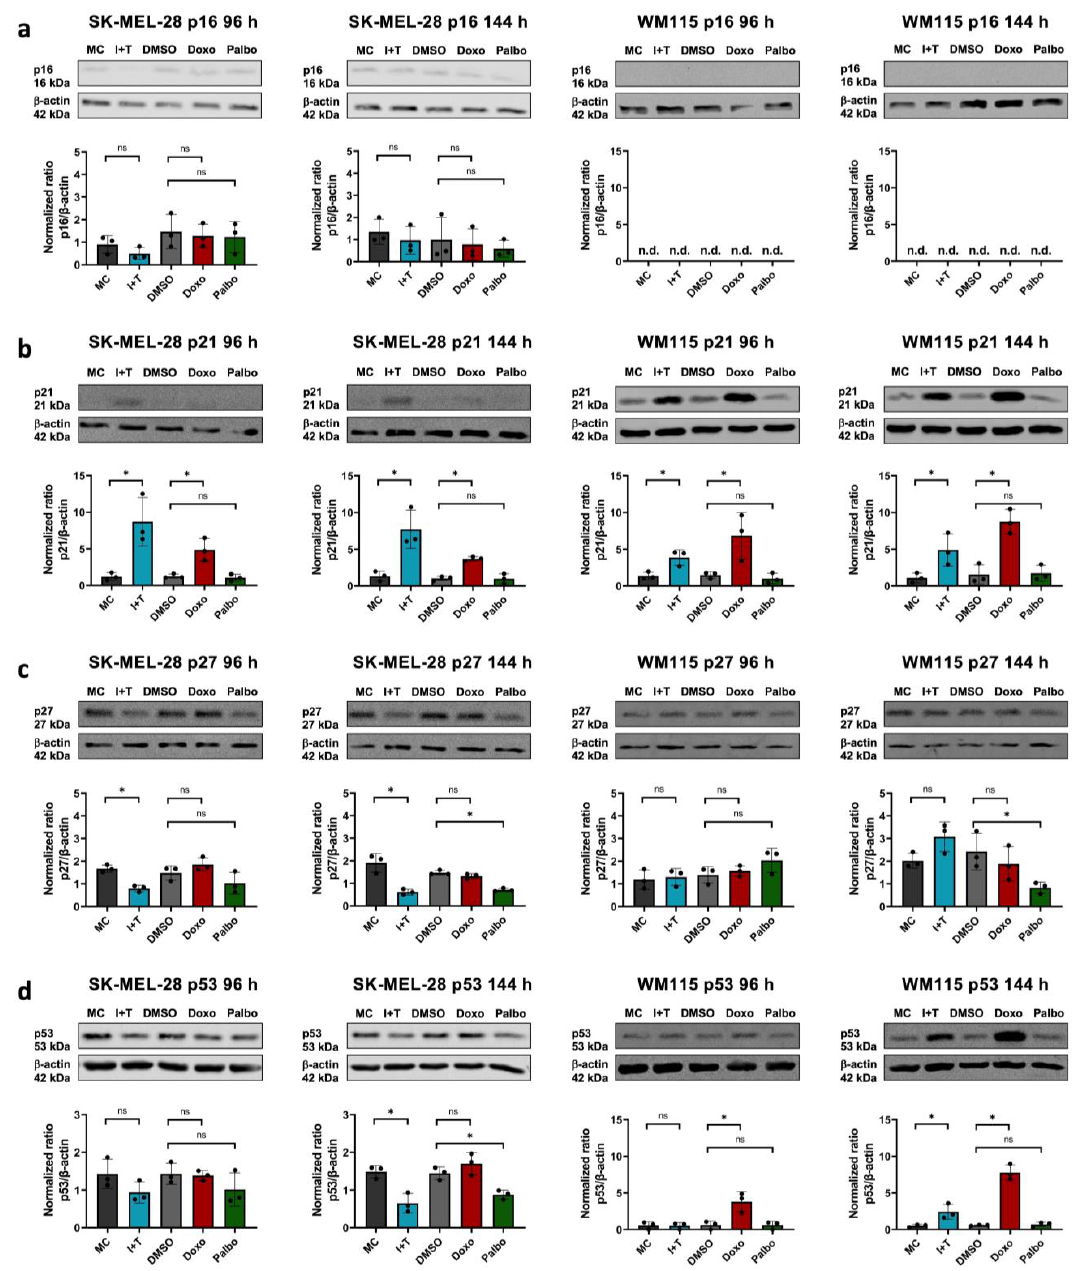
Figure 3. Induction of the cell cycle inhibitor p21 in melanoma cells after cytokine and doxorubicin treatment. Original Western blots (upper row) of p16 ( a ), p21 ( b ), p27 ( c ), and p53 ( d ) in SK-MEL-28 (first and second column) or WM115 (third and fourth column) melanoma cells treated with IFN- γ and TNF (I+T), doxorubicin (Doxo), and palbociclib (Palbo) for 96 h or 48 h after the end of treatment (144 h) as indicated. MC, medium control. DMSO, vehicle control. Lower panels show the semiquantitative densitometric analysis of p16 ( a ), p21 ( b ), p27 ( c ), and p53 ( d ) expression (upper row) and normalization to β -actin (lower row). The respective ratio of each control and treatment was normalized to the medium control at 0 h, which was set as 1 (data not shown). Results are from three independent experiments ( n = 3); n.d., not detectable; ns, not significant; unpaired Student’s t -test; mean ± s.d.; an asterisk (*) indicates a significant difference from the respective controls with p <